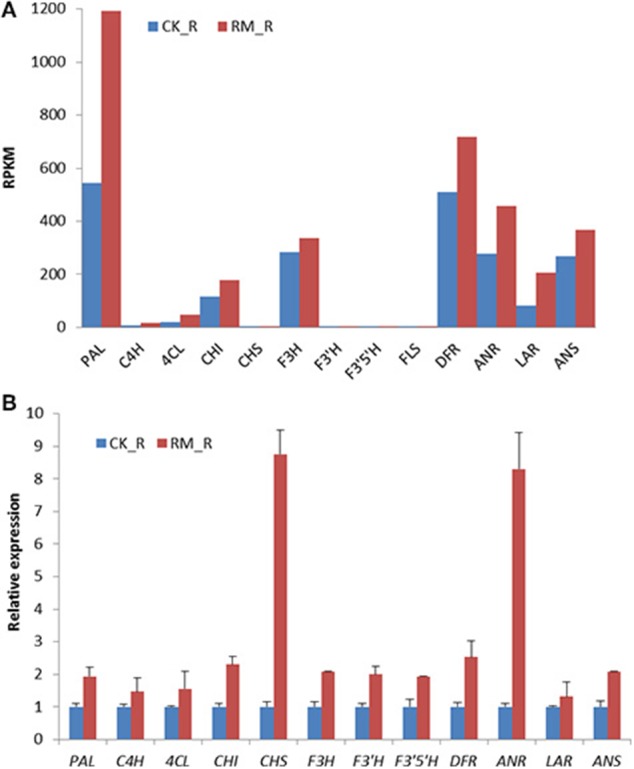
Expression pattern of genes involved in flavonoid biosynthesis in RM_R and CK_R plants by RNA-seq and qRT-PCR analyses. (A) Flavonoid biosynthesis-related genes detected by RNA-seq analysis. (B) Selected genes selected are confirmed by qRT-PCR analysis. The relative expression fold was calculated by using the 2−ΔΔCt method. The Ct-values for unigenes in CK_R plants was arbitrarily chosen as the calibrator. Results represent the means ± standard deviation of triplicates.